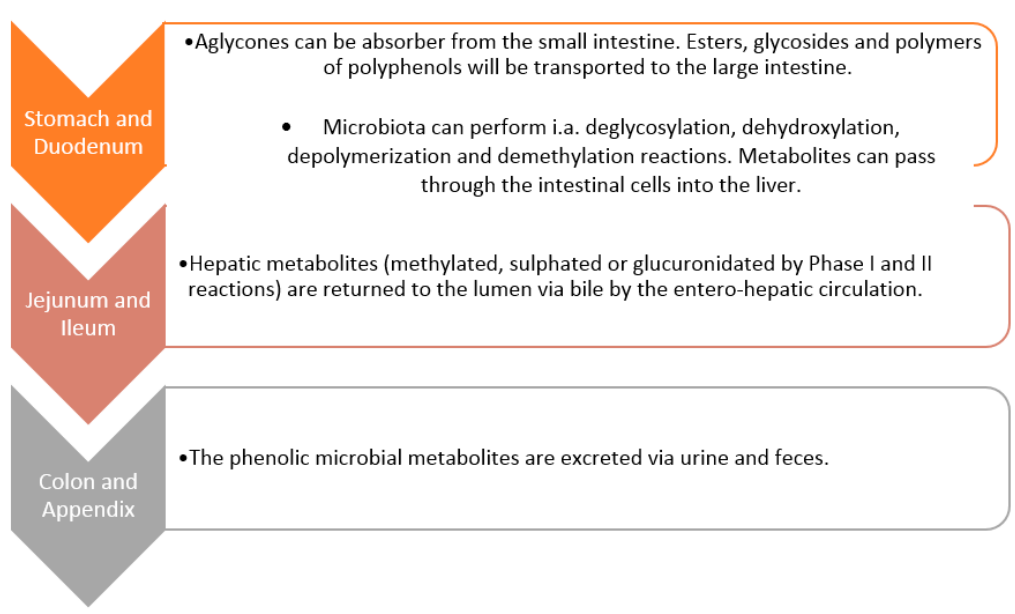
Figure 5. Scheme of microbial metabolism of polyphenolics in the gastrointestinal system. E. coli, Bifidobacterium sp., Eubacterium sp., Bacteroides sp. and Lactobacillus sp. hold